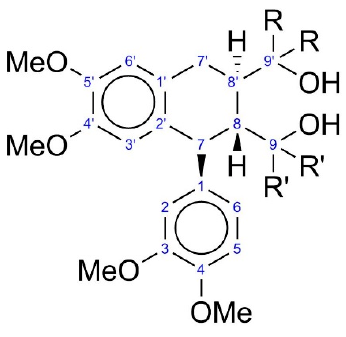
Figure 1. General structure and numbering of atoms of the LIGNOLs (R, R ′ = phenyl, methyl or hydrogen, which is explained in more detail in Table 1). Table 1. Description of the investigated structures.